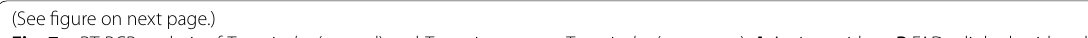
(See figure on next page.) Fig. 7 qRT-PCR analysis of T. versicolor (control) and T. coccinea versus T. versicolor (treatment). A Amine oxidase. B FAD—linked